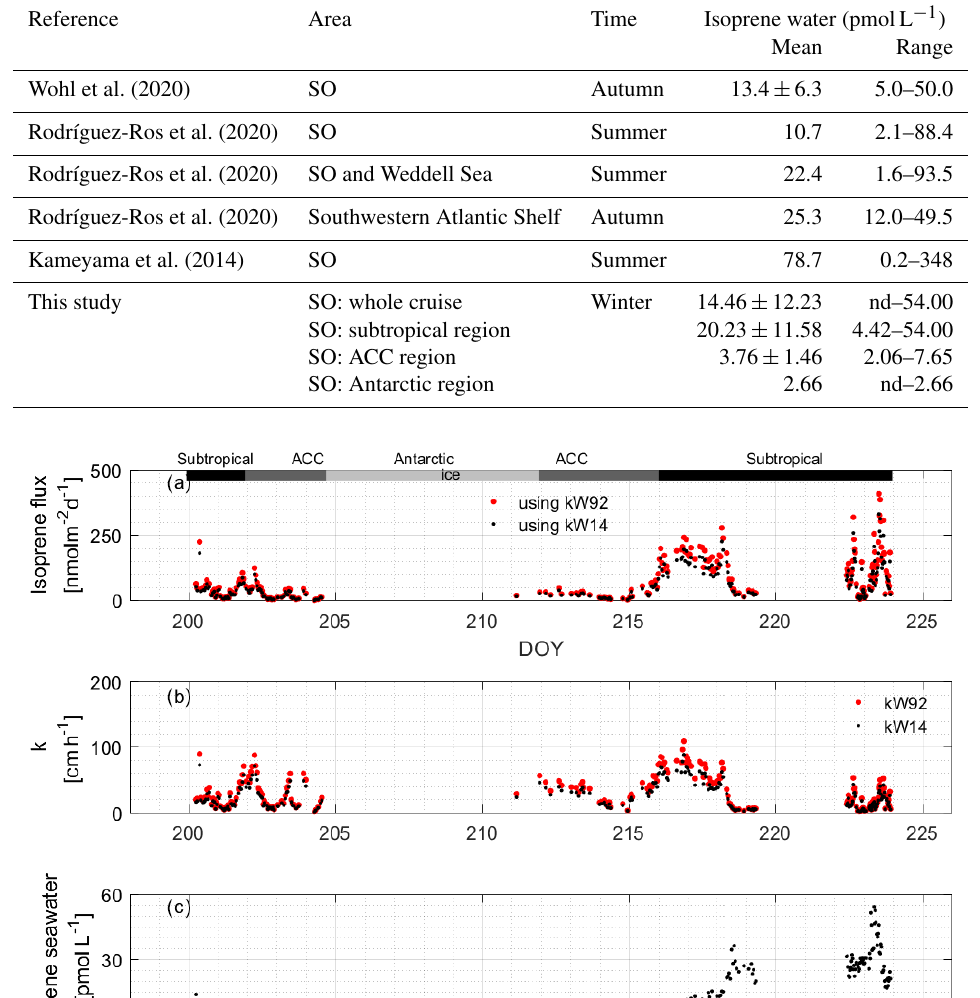
Table 2. Isoprene seawater concentration observations in the Southern Ocean (SO).